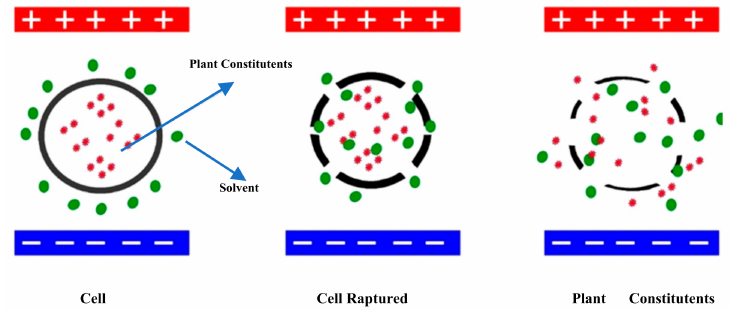
Figure 1. Electroporation mechanism for